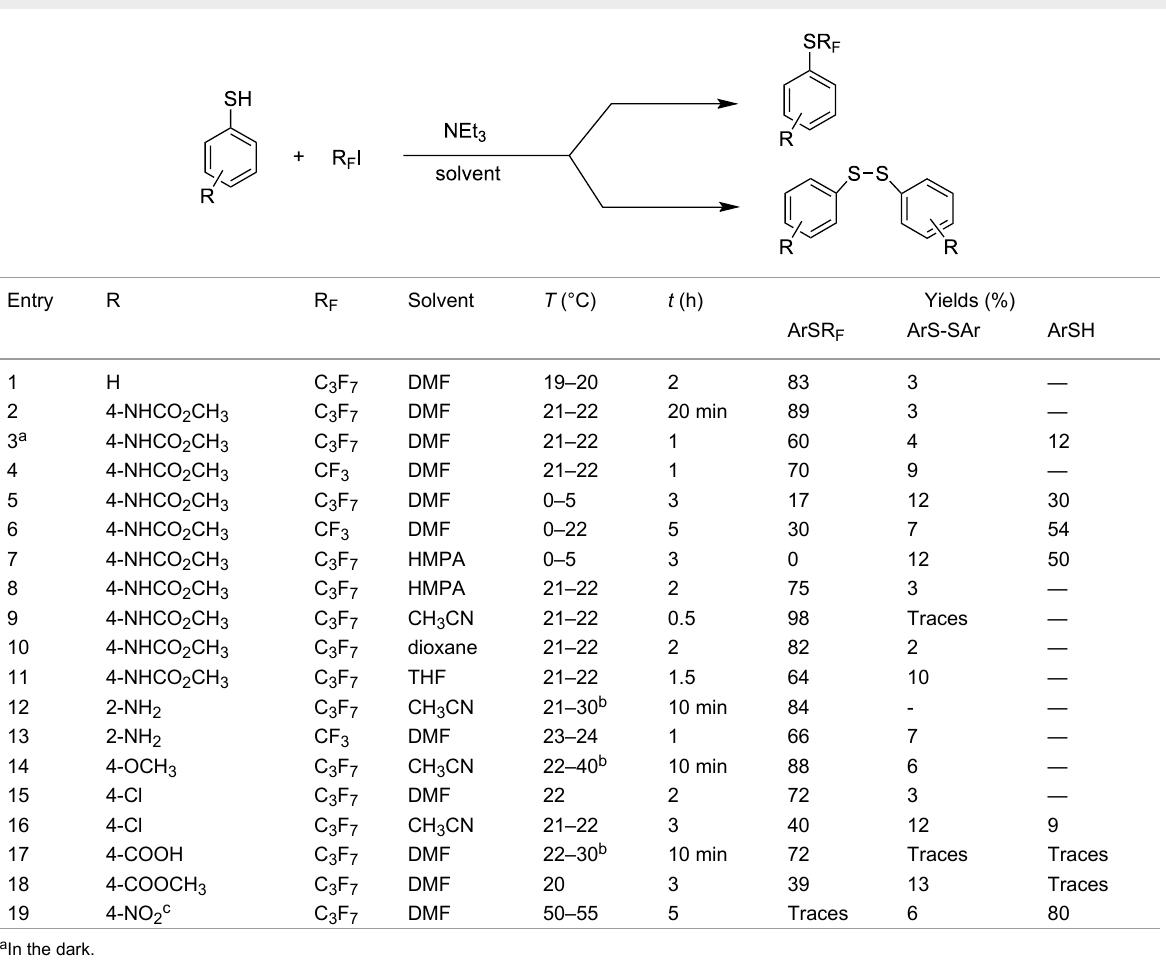
Table 12: Reaction conditions of thiophenoxides RC 6 H 4 S − Et 3 NH + with R F I without irradiation [189].